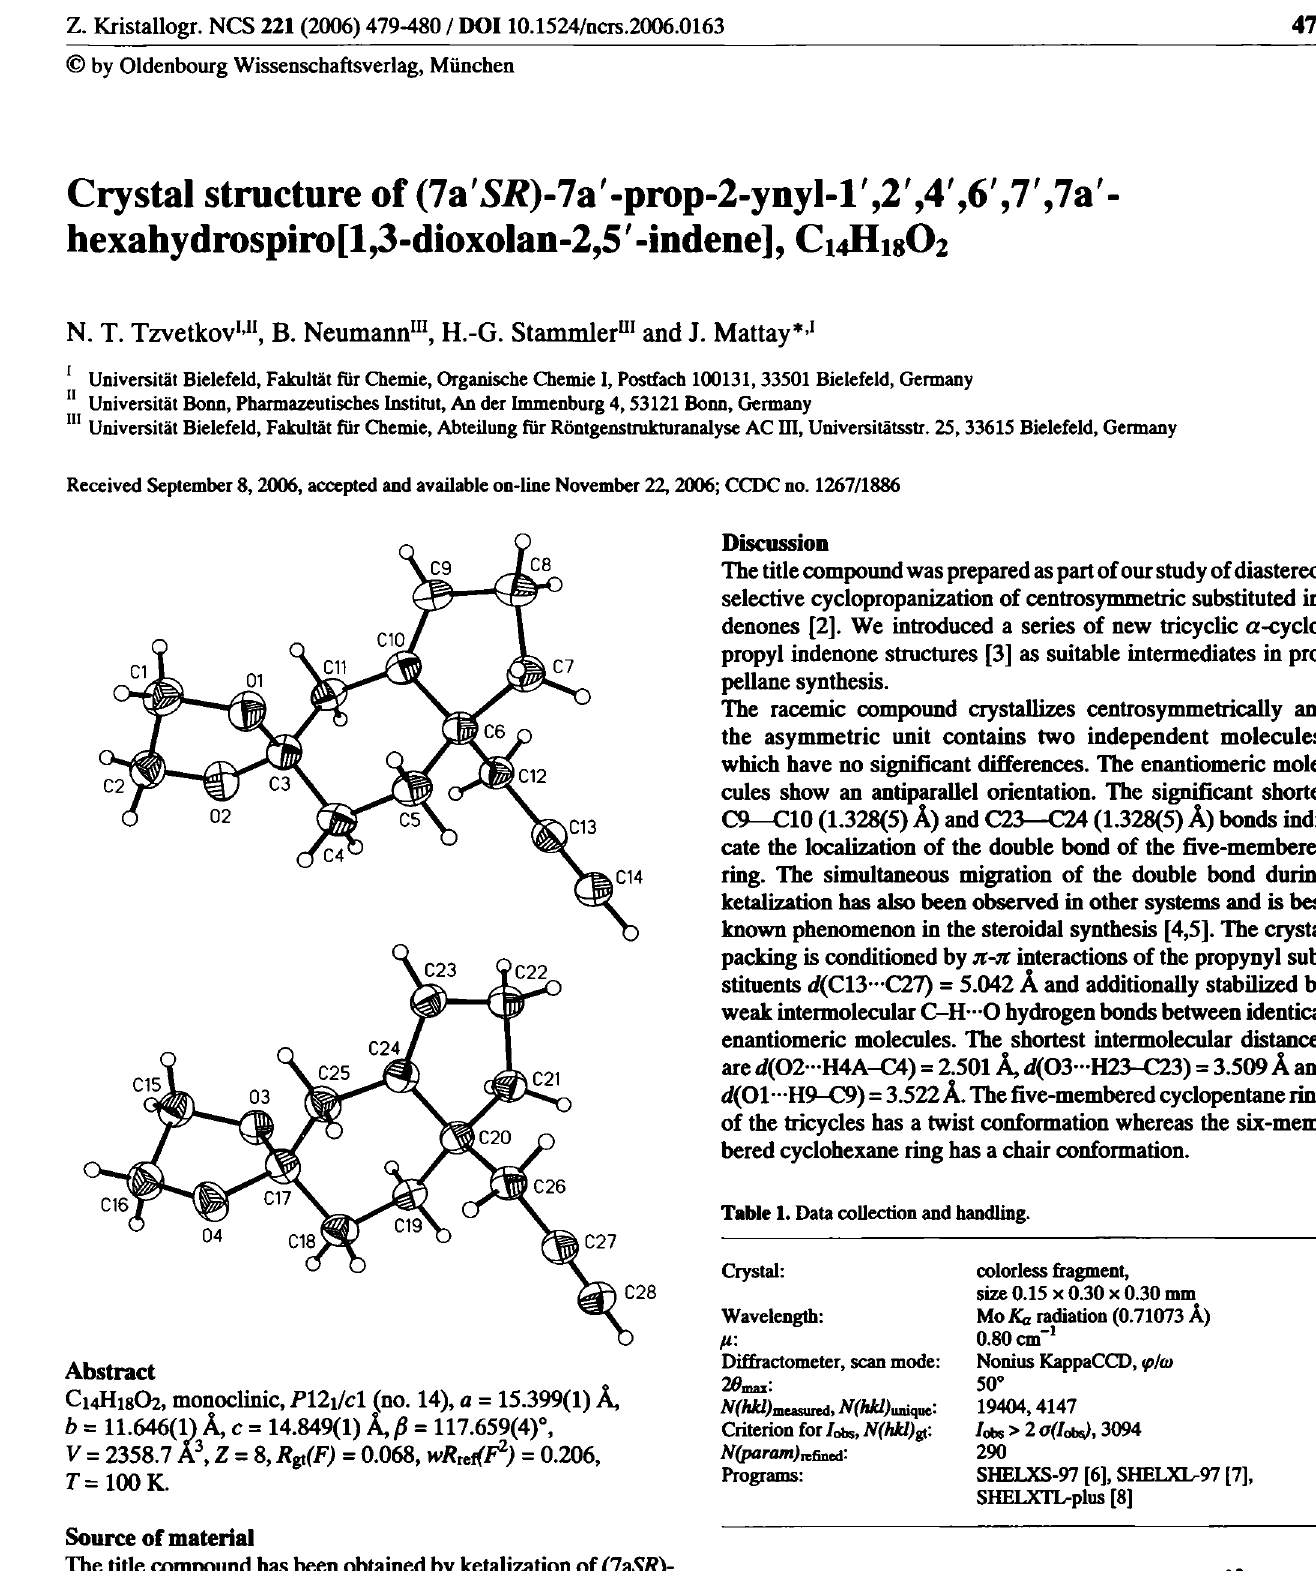
Table 2. Atomic coordinates and displacement parameters (in A 2